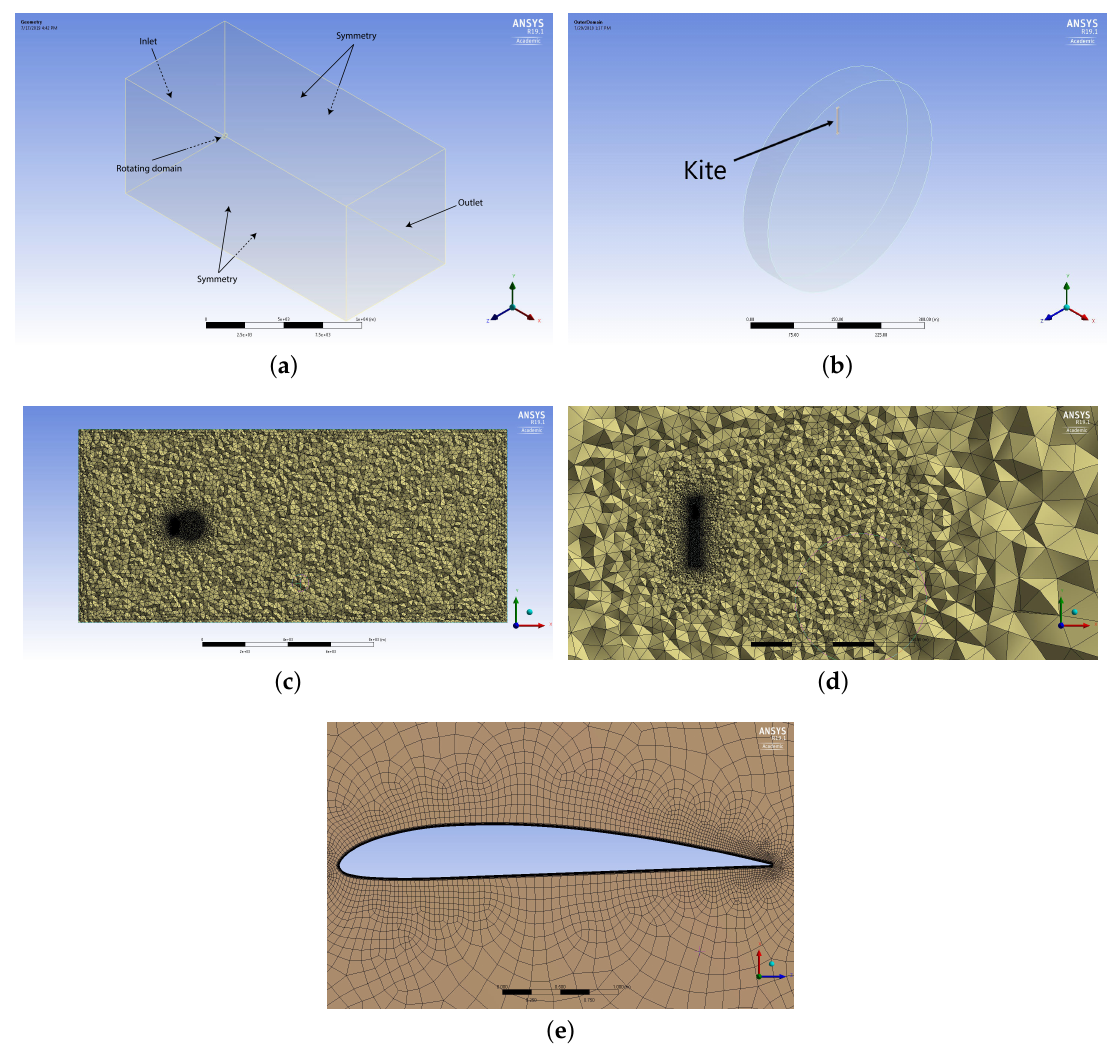
Figure 2. The setup of the CFD simulation of the kite: ( a ) the solution domain that is 20 × 9 × 9 km (L × W × H); boundary conditions are: velocity inlet, pressure outlet, symmetry over the top, bottom and sides of the domain, and no-slip over all the faces of the kite, ( b ) the rotating domain (radius: 180 m); a non-conformal domain is created between the stationary and rotating domains, ( c ) the top-view of the solution domain mesh (6.9 M cells, and 3.8 M nodes) with the ‘sphere of influence’ downstream of the kite, ( d ) mesh in the vicinity of the rotating domain, and ( e ) mesh around the kite airfoil section (Clark Y airfoil, chord: 3.72 m, Max. thickness: 0.43 m, No. of hexahederal elements around the airfoil: 3M, bias factor at the L.E. and T.E.: 2 and 10, No. of inflation layers around the airfoil: 22, the growth ratio: